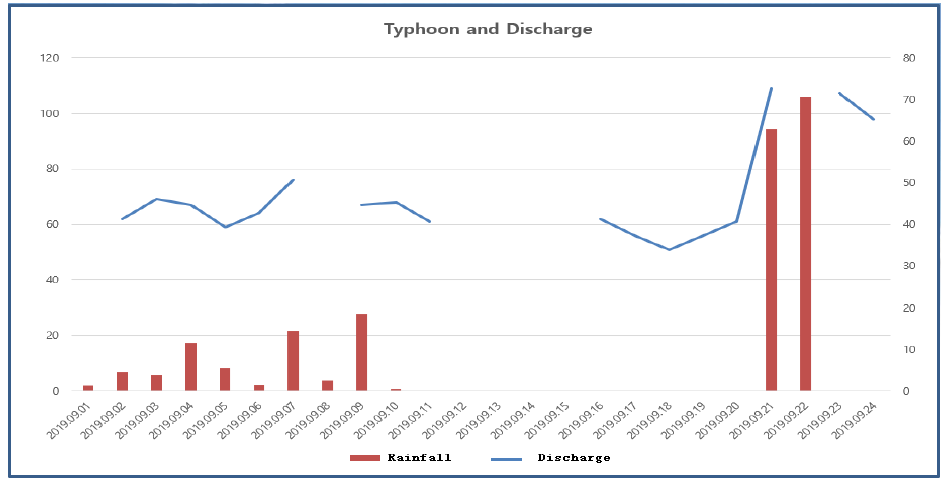
Figure 28. Increase in precipitation during typhoons.